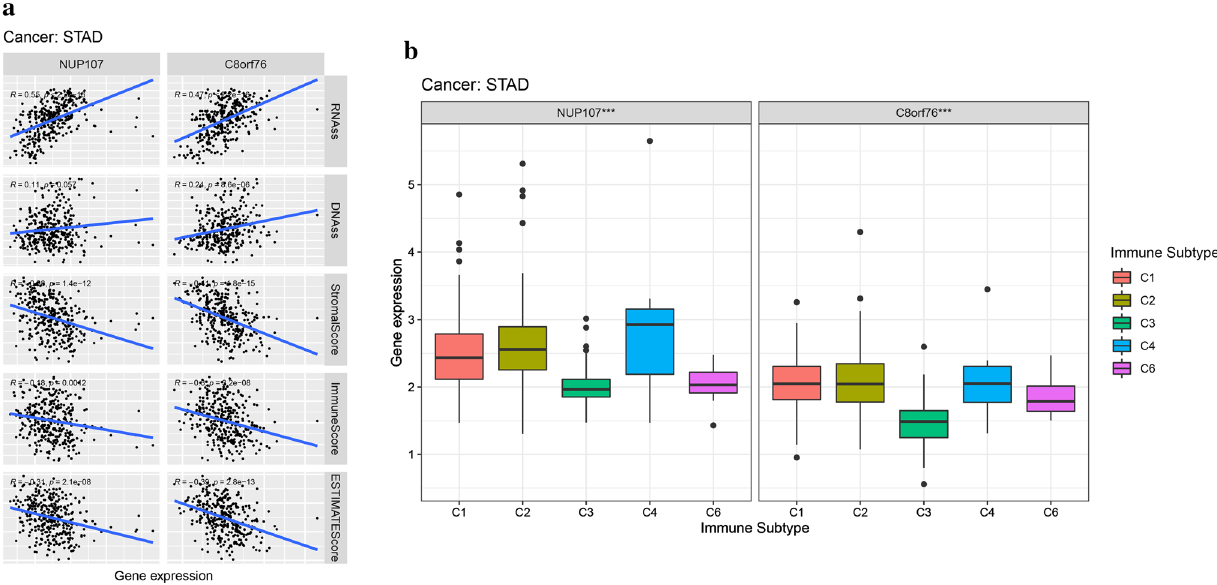
Fig. 11 Correlation analysis of NUP107 and C8orf76 expression and GAC microenvironment, stem cell scores, and immune subtype. a The correlation between NUP107 and C8orf76 expression and RNAss, DNAss, immune score, estimate score, and stroma score. b The correlation between NUP107 and C8orf76 expression and immune subtype. * P < 0.05, ** P < 0.01, *** P <